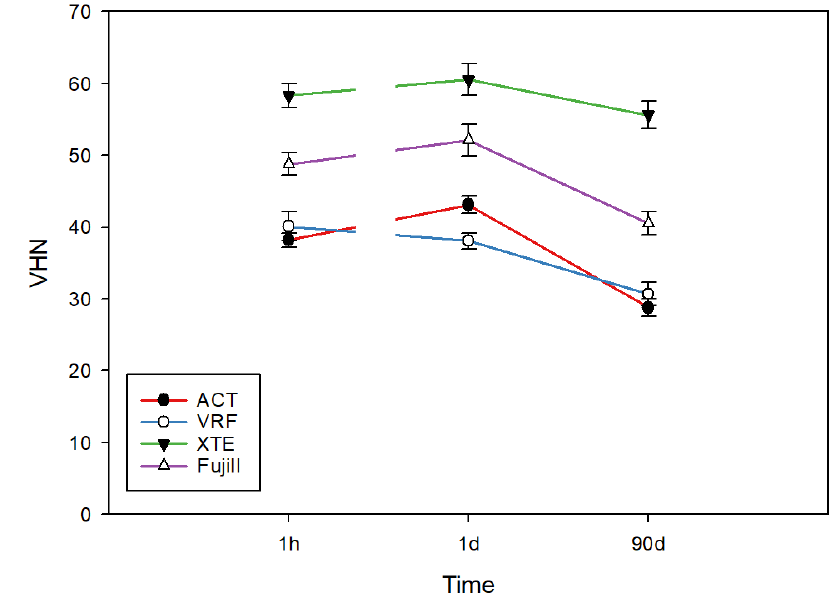
Figure 1. Vickers hardness (VHN) of materials measured at three time intervals: after 1 h dry, after 1 d, and after 90 d at 37 °C . The broken line indicates that the 1 h time point was obtained under dry storage while 1 and 90 d were obtained after underwater storage at 37 °C . n = 12 samples for all tests.